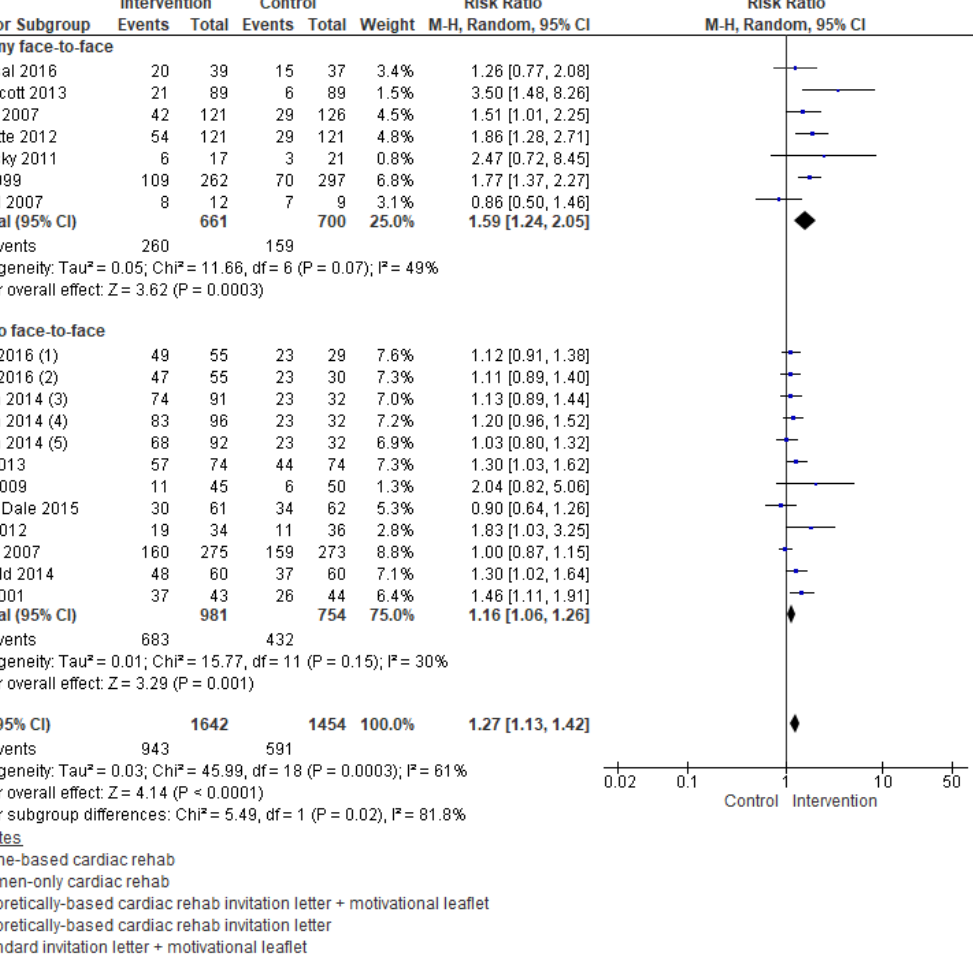
Figure 5. Forest plot for the enrollment—delivery format. Note: Boxes represent the risk ratio (RR) for individual trials. The boxes are proportional to the weight of each study in the analysis and the lines represent their 95% confidence interval (CI). The diamond represents the pooled RR, and its width represents its 95% CI.